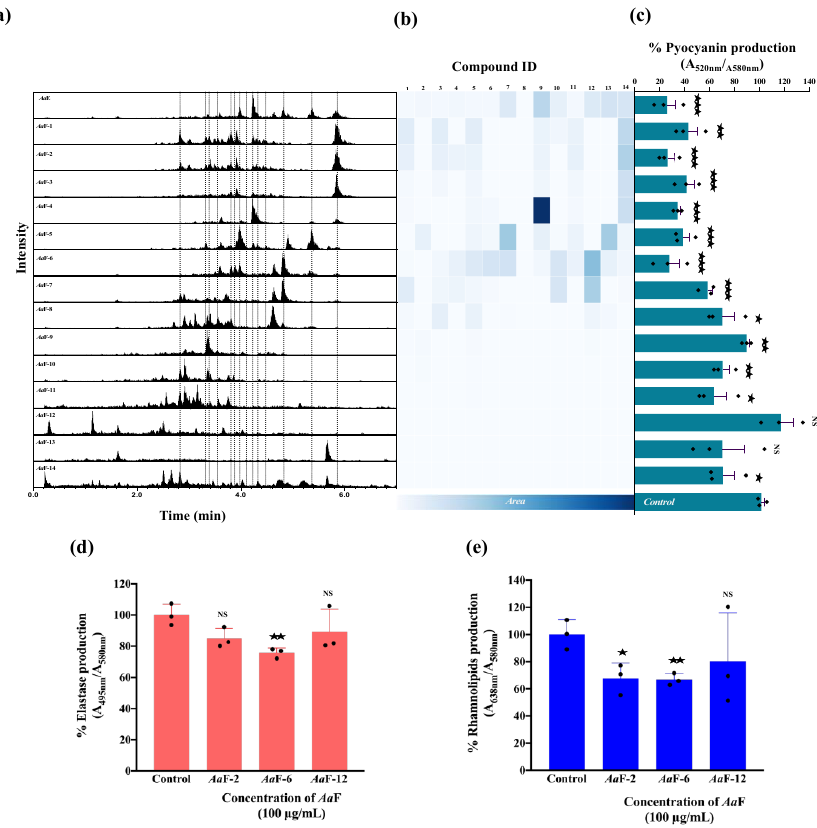
Figure 7. ( a ) Total ion current chromatograms of Aa E and its fractions ( Aa F). Dashed lines indicate the retention time of the dereplicated compounds (1 to 14, left to right). ( b ) Heatmap based on the ESI- negative total ion current chromatogram peak integration of dereplicated compounds in the Aa E and all Aa F. ( c ) Effect of Aa E and each of the fourteen Aa F on the production of pyocyanin by P. aeruginosa . ( d ) Effect of Aa F-2 and Aa F-6 (diterpene-enriched fractions) and Aa F-12 on P. aeruginosa elastase and ( e ) rhamnolipids production. Data represent mean ± SEM of at least three independent biological assays. Significant differences between mean values versus control conditions were assessed via online graph pad t- test calculator. ★★★ , p = 0.0001–0.001; ★★ , p = 0.001–0.01; ★ , p = 0.01–0.05; NS: (not significant), p > 0.05.